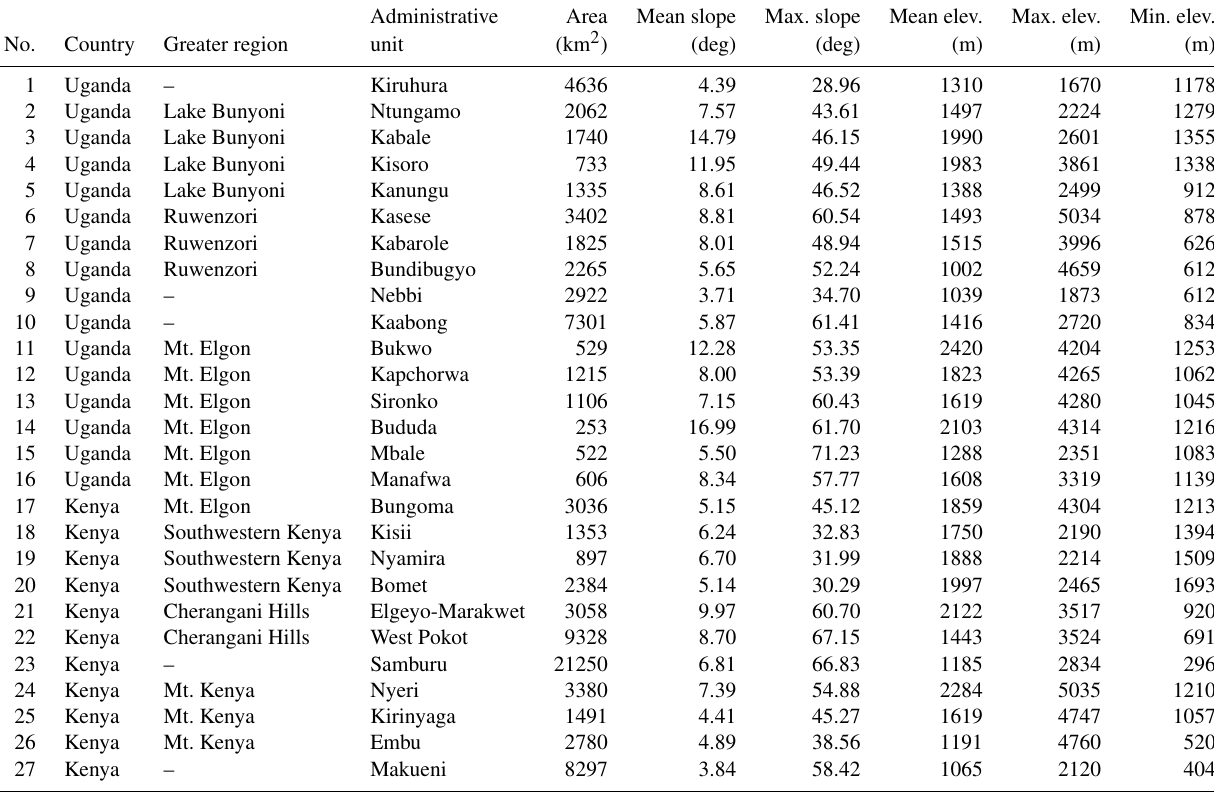
Table 1. Administrative units analyzed in more detail. The locations are shown in Fig. 1a. The slope and elevation statistics are based on the SRTM v4.1 90m DEM (Jarvis et al.,